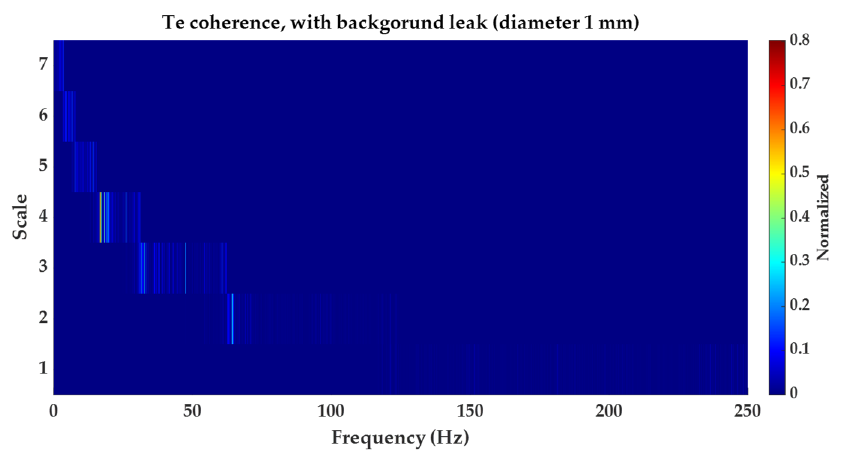
Figure 15. T e coherence, with background leak (1 mm in diameter) and flow rate 33.7 mL/s.